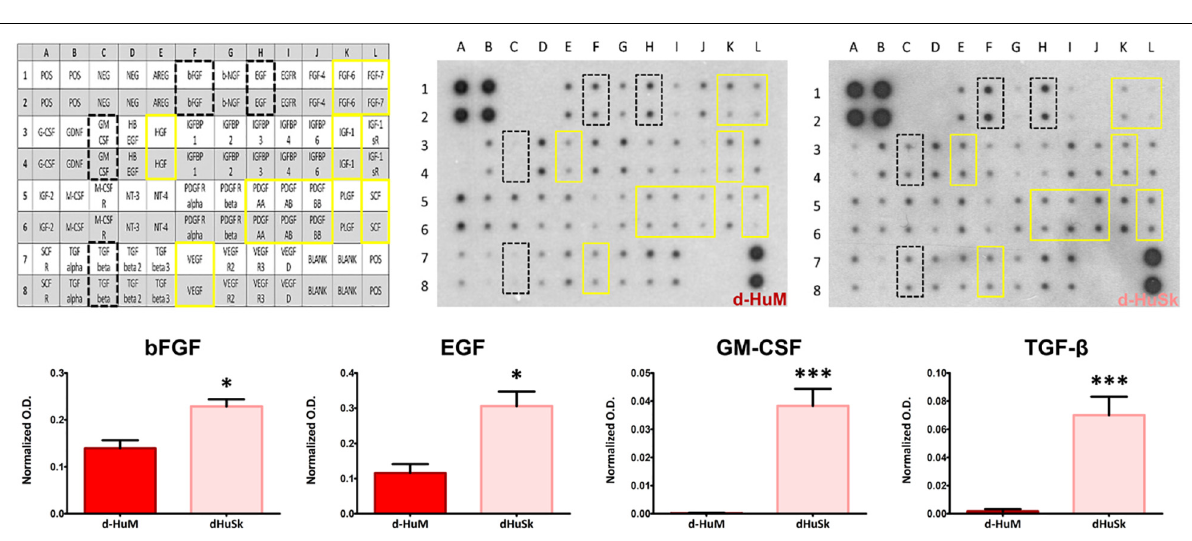
FIGURE 5 | Comparative analysis and quantification of growth factor content in d-HuM and d-HuSk. The representative images of the protein array membranes showed that nine of the targeted growth factors were present both in d-HuM and d-HuSk without any significant difference (yellow solid squares), while bFGF, EGF, GM-CSF, and TGF-beta (black dotted squares) were present at a significantly higher concentration in d-HuSk, as confirmed by the quantification shown by the graphs. In the upper left corner, the array map is shown as a reference. Asterisks were used to report significance in each comparison as follows: significant (* p ≤ 0.05) and very significant (*** p ≤ 0.001). O.D.: optical